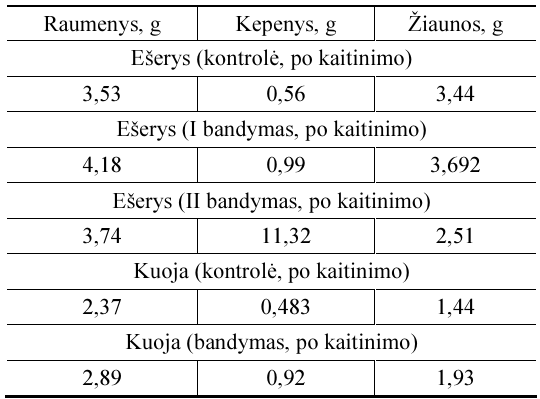
Table 2. Net weight of sample mass of perch and roach repro- duced in natural living condition